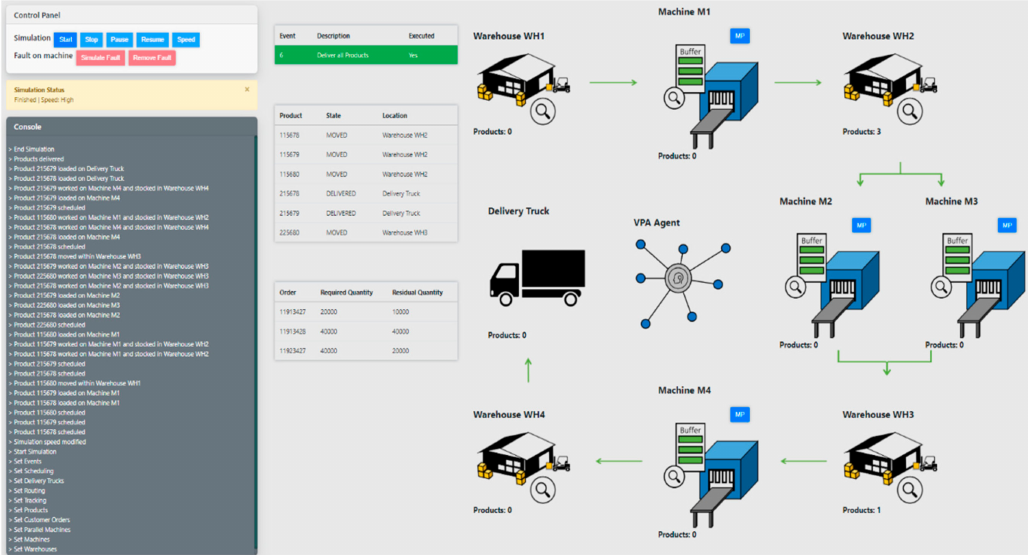
Figure 12. Undisturbed scenario at the end of the